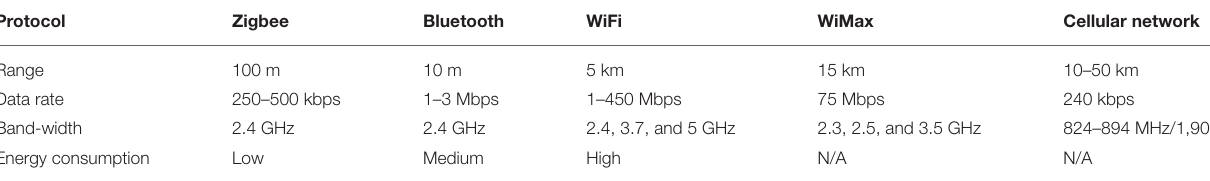
TABLE 8 | Comparison of different kinds of communication protocol.